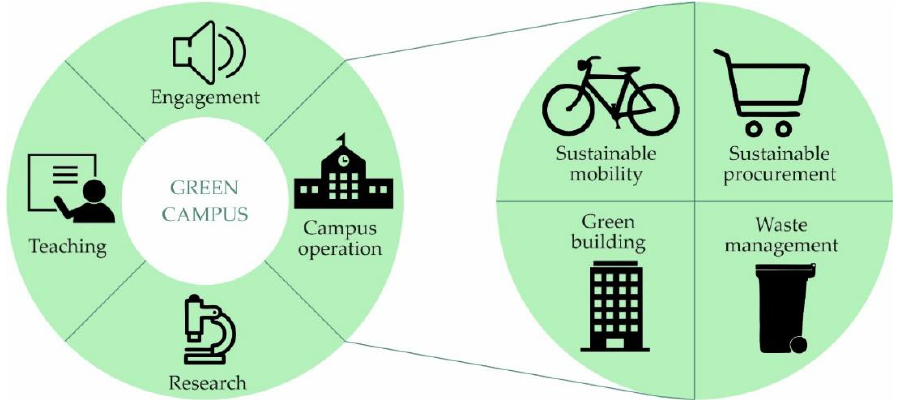
Figure 1. Green campus framework. Source: Authors’ own. Based on Fissi et al., (2021) [27].